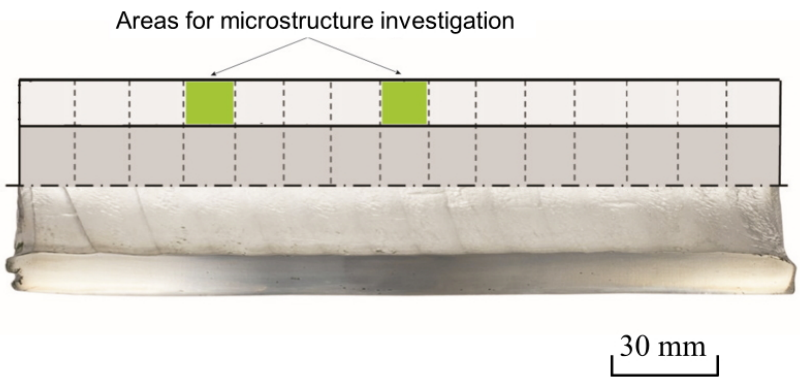
Figure 3. Location scheme of the samples used for the microstructure investigation in the longitudinal section of the hollow shell.